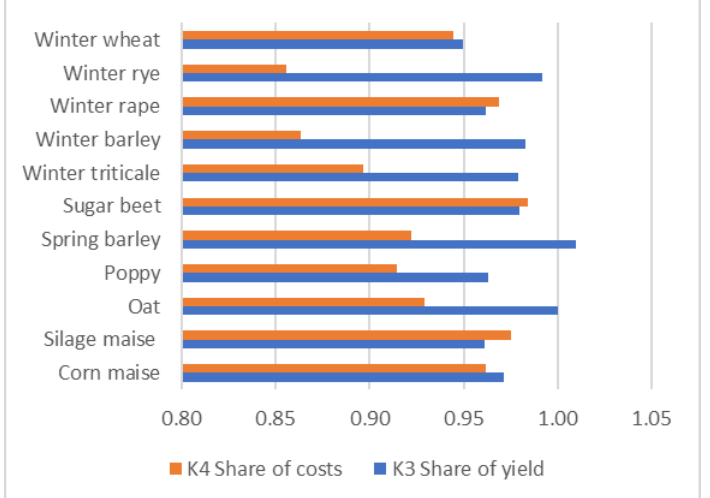
Figure 4. Share of yields K 3 and costs K 4 on main crops. The costs of RT for some crops (K4 coefficient for grain maize 0.96, silage maize 0.97, winter rape 0.97, winter wheat 0.94, sugar beet 0.98) showed a similar trend as for